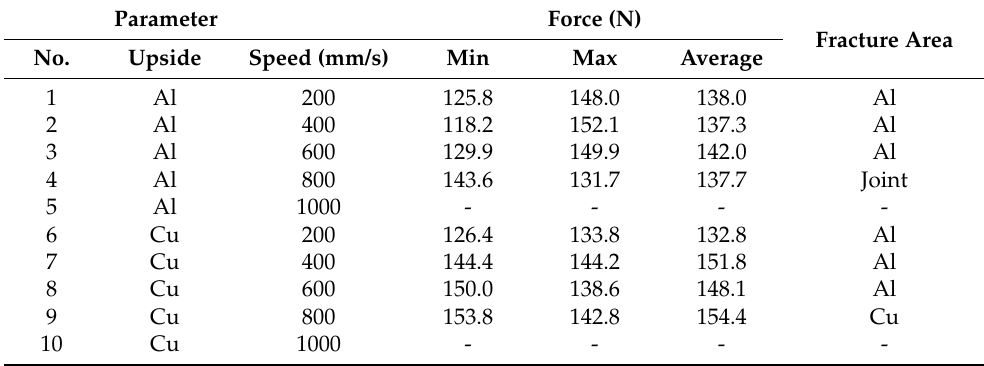
Table 3. Results of the tensile shear strength tests.